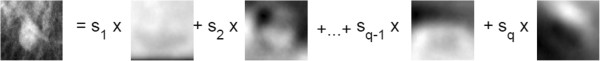
Decomposition of the image using an ICA base: The figure shows how an image can be decomposed using the inverse of an ICA base (image basis) and the eigenimage coefficients obtained by applying that base.